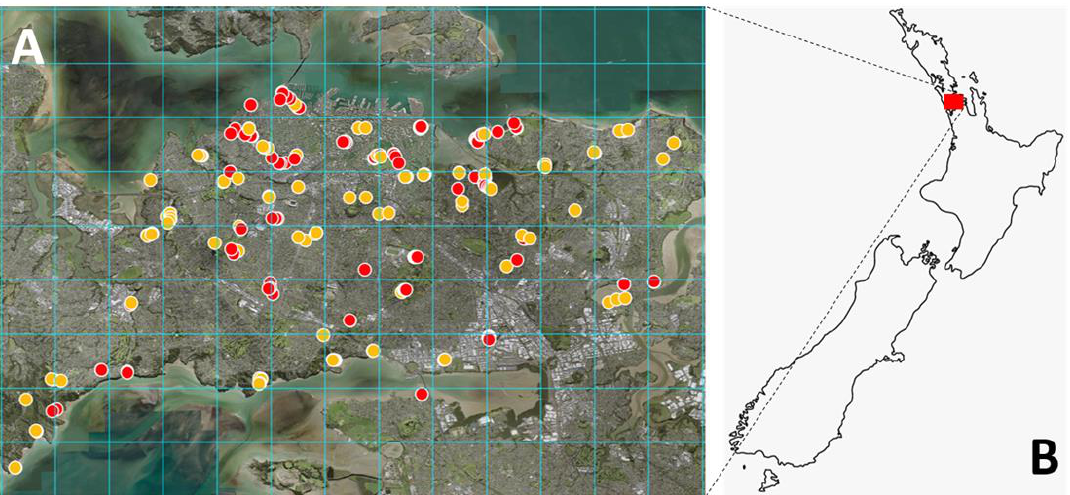
Viruses 2021 , 13 , x FOR PEER REVIEW Figure 4. Distribution of Karaka ¯Okahu purepure virus in central Auckland as assessed by visual symptoms. ( A , B ) Red dots represent symptomatic trees, orange dots represent asymptomatic trees. This map is overlaid with a 2 km × 2 km grid.